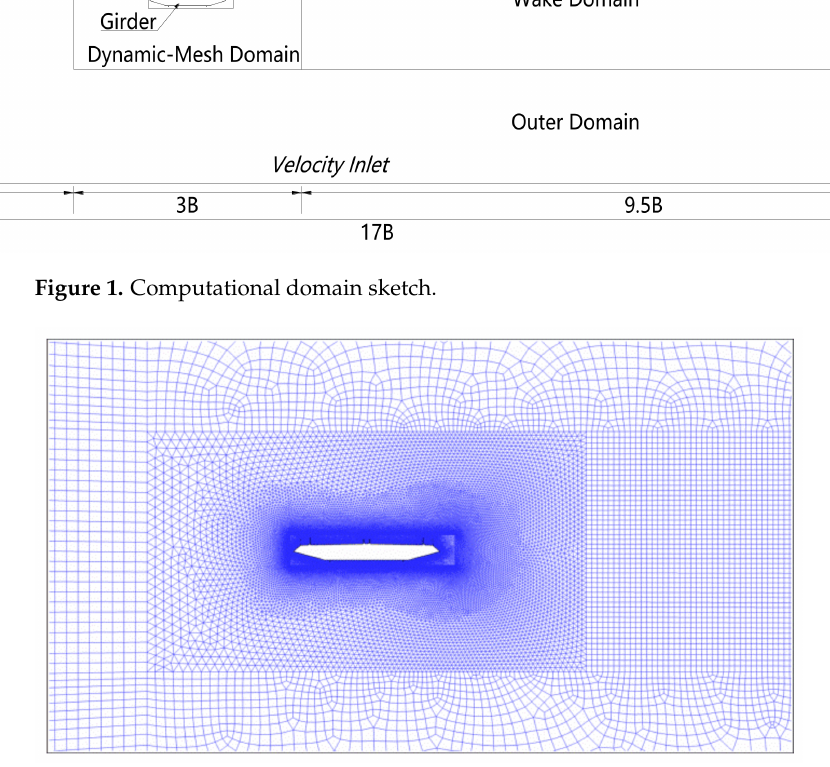
Figure 2. Meshing